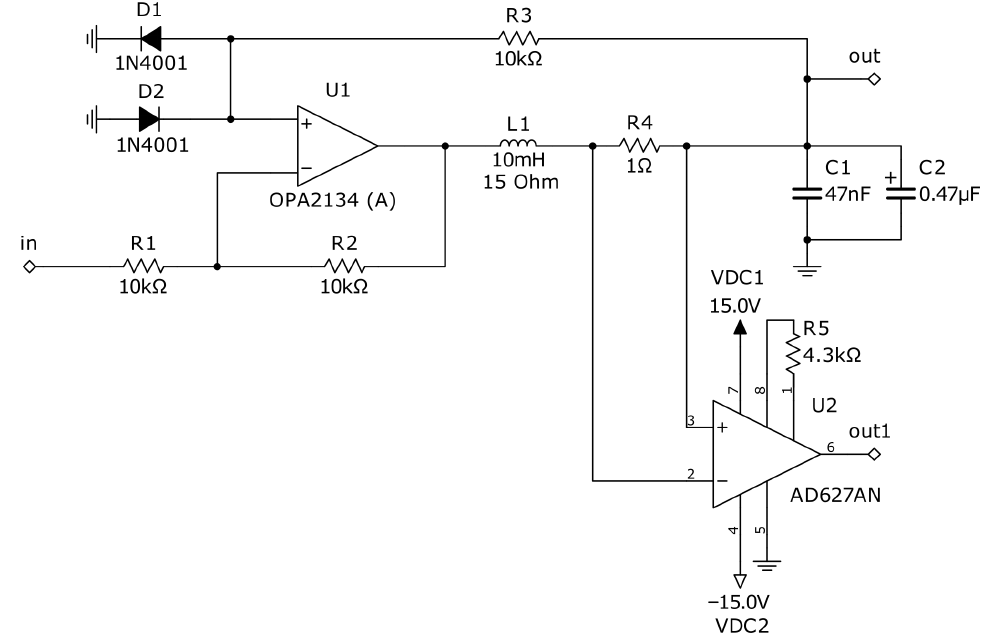
Figure 5. Circuit implementation of a Duffing oscillator with diodes and inductive coil used in our study. The instrumental amplifier U2 allows observing the current in the coil L1, which is one of the state variables. Output out allows observing the voltage state variable, and out1 —the current. In the practical design, out1 is not required, as it is used only to obtain a two-dimensional phase